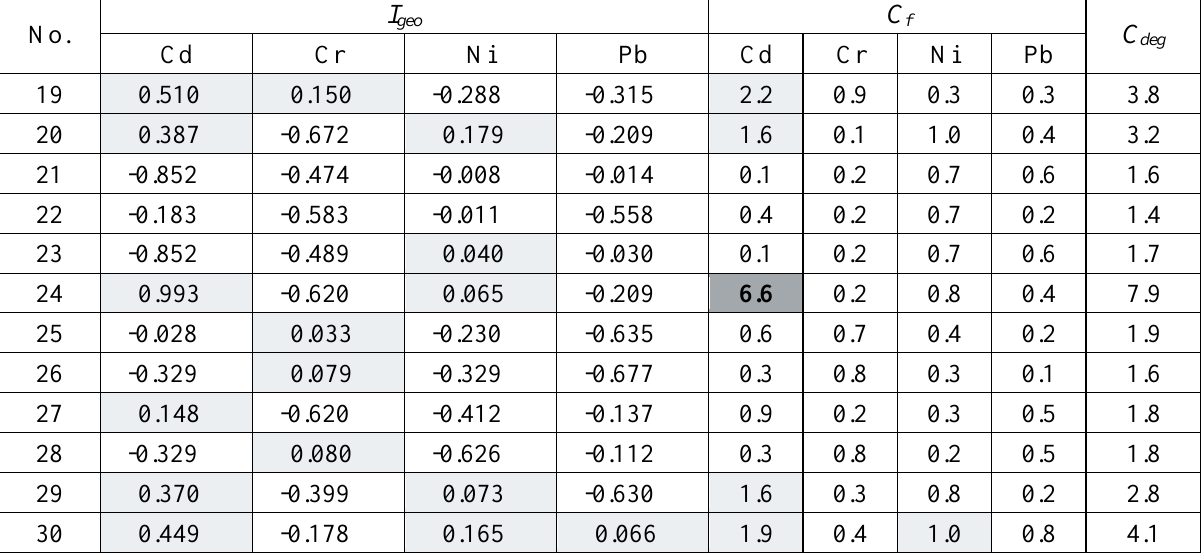
Table 4. Geoaccumulation index ( I geo ) and contamination factor ( C f ) for individual trace elements, and the degree of contamination ( C deg ), in hollows of raised bogs on Bolshoy Solovetsky Island. For key to shadings, see the caption of Table 3.